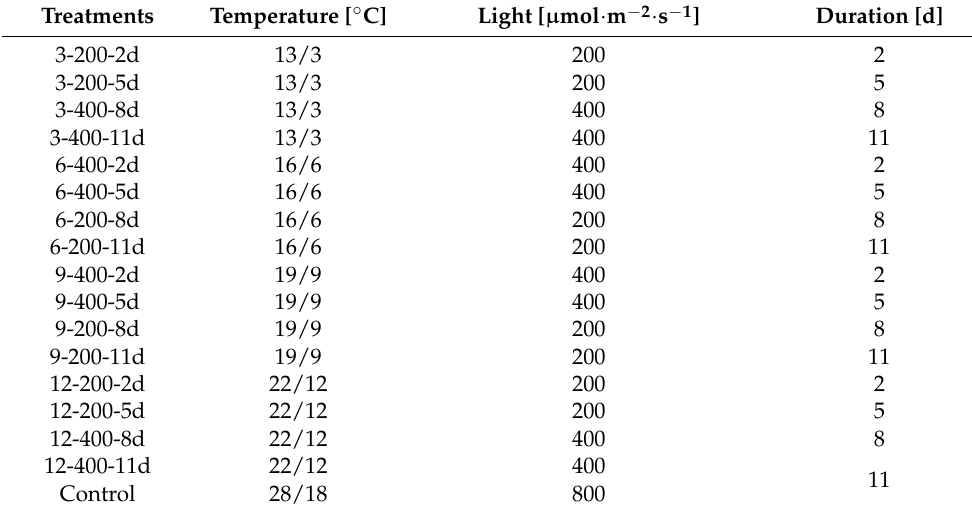
Table 1. Orthogonal experimental